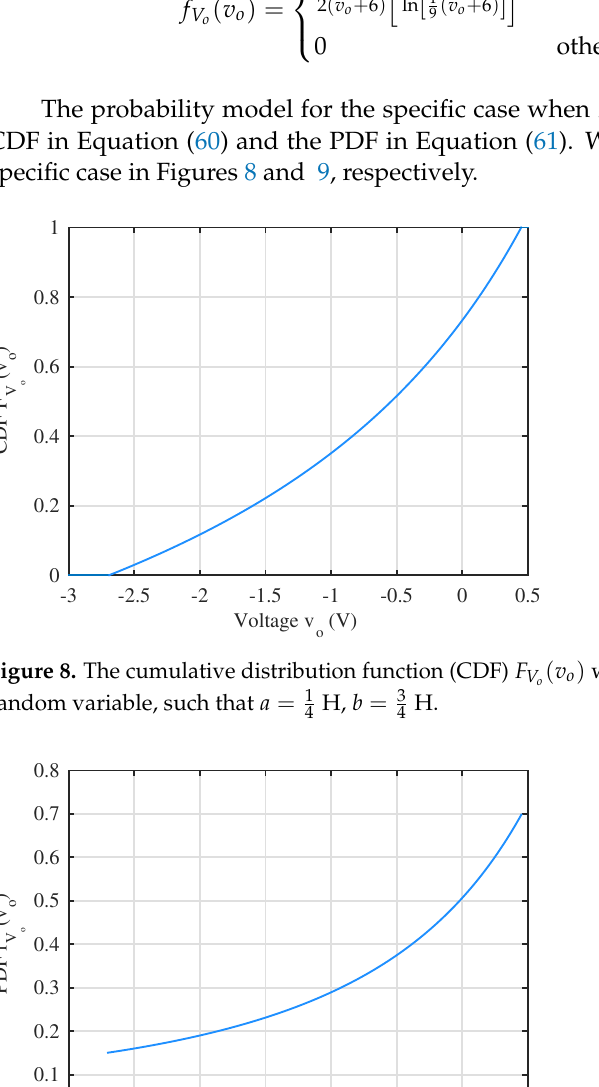
Figure 9. The probability density function (PDF) f V random variable, such that a = 1